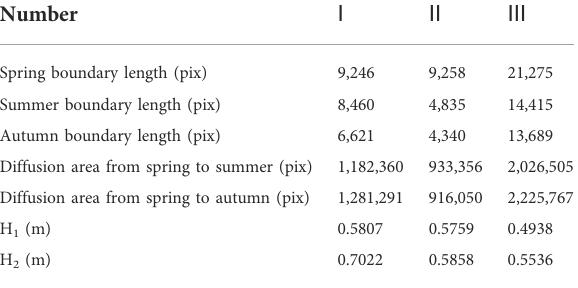
TABLE 3 Statistical value of S. alterni fl ora diffusion index.